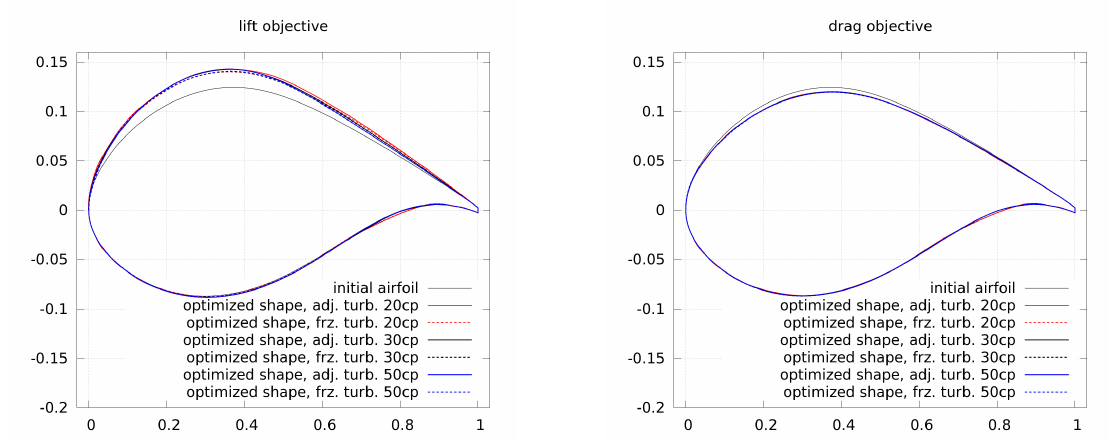
Figure 17. Airfoil shapes using adjoint and frozen turbulence for the lift and drag objective for DU 93-W-210 at AoA = 6 ◦ . Frozen as well as adjoint turbulence are used. The number of control points is labeled as “XXcp”.